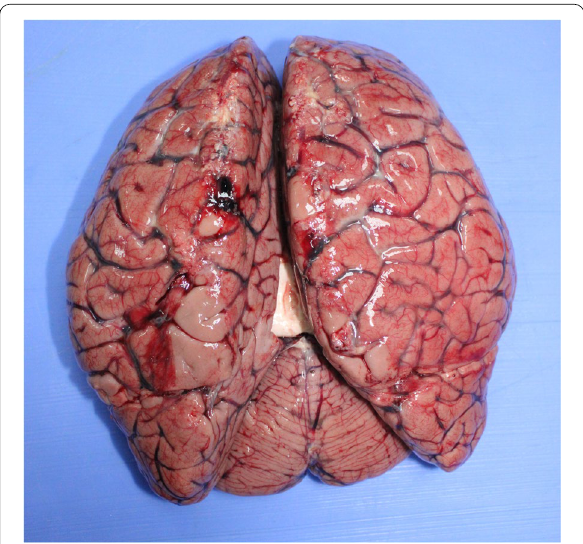
Fig. 2 Representative image of the brain at autopsy showing congestion and